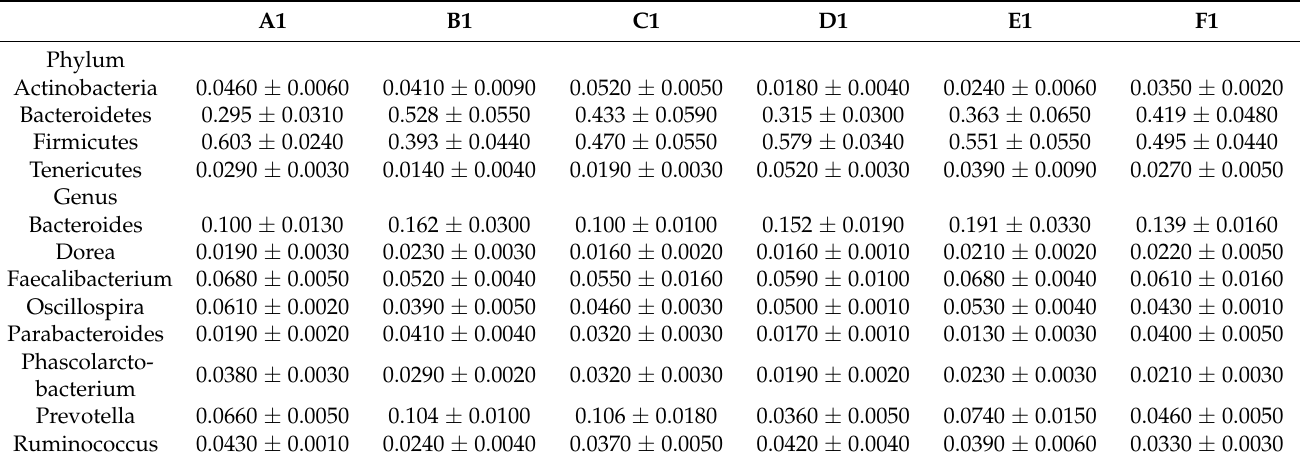
Table 6. The relative abundance of dominant bacteria from different groups on day 28.